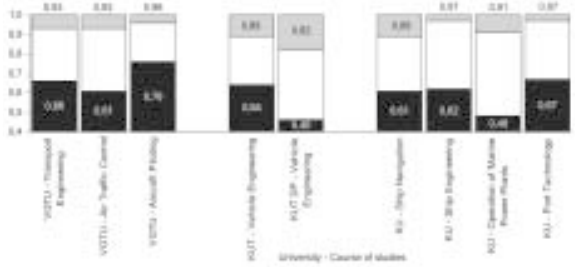
Fig 8. The relationship between the lowest (the upper limit of a black shaded area) and the highest (the lower limit of a grey shaded area) competitive marks and the highest possible marks for taking the full-time studies in transport engineering courses in 2005